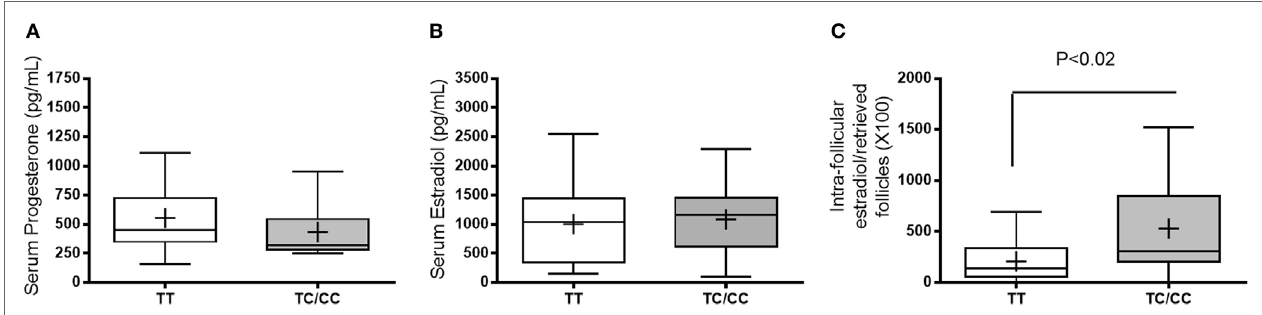
FigUre 2 | Serum concentrations of progesterone (a) and estradiol (B) on the day of human chorionic gonadotropin administration and the ratio of serum estradiol/to retrieved follicles (c) . White bars represent women carrying the TT genotype, whereas the gray bars represent women carrying the TC/CC genotypes. Unpaired t -test. The data are presented as the mean ± min and